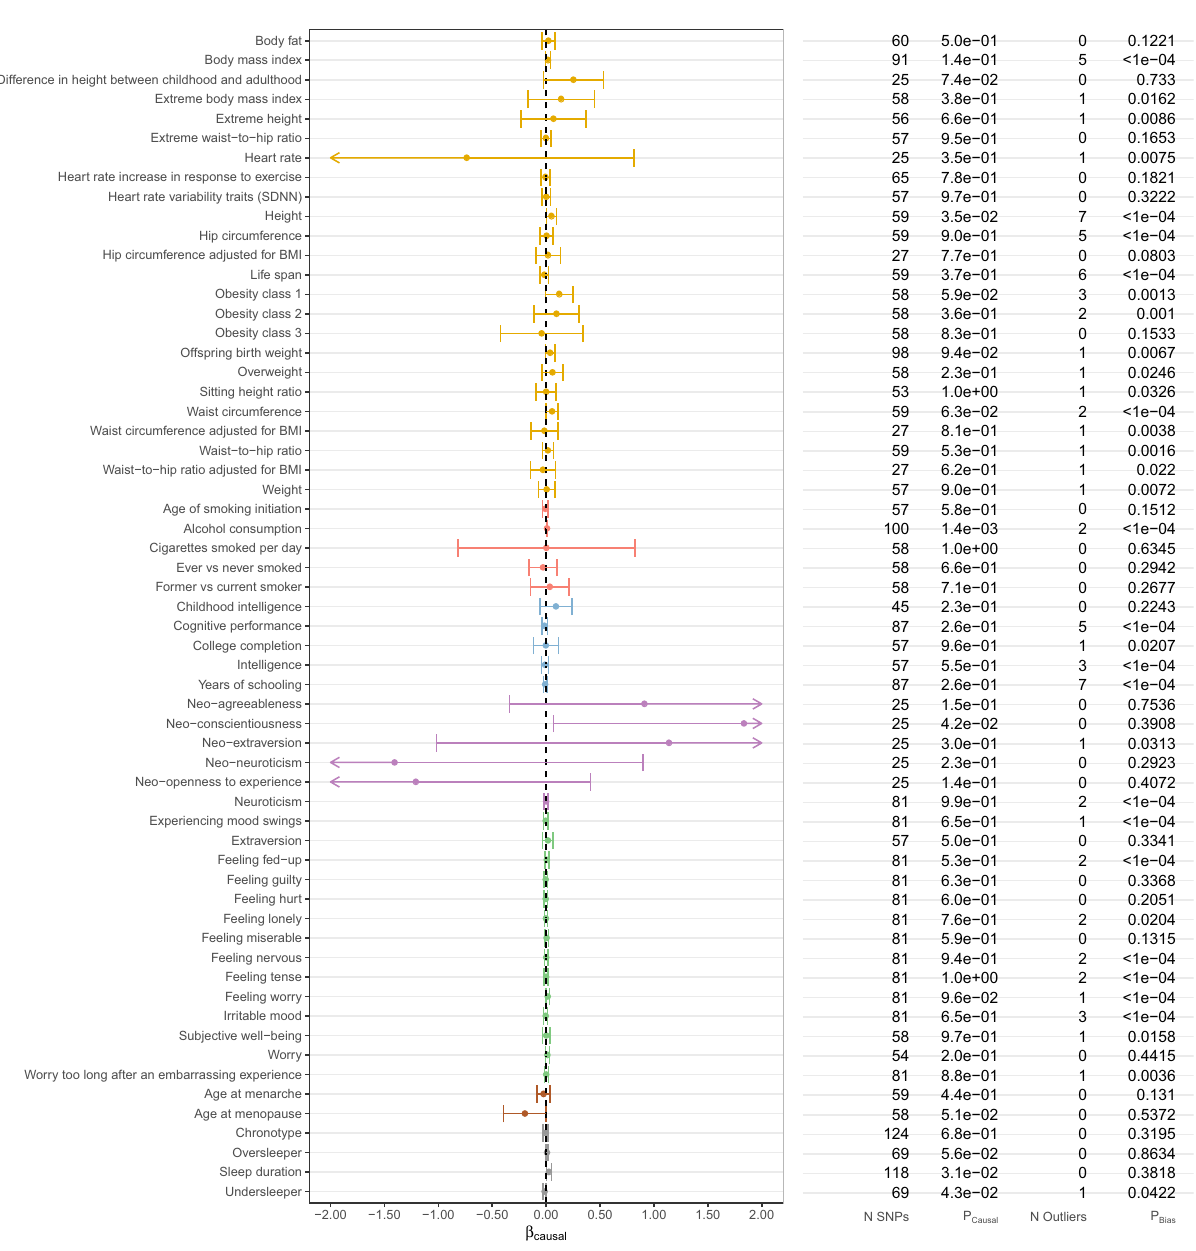
Figure 2. Estimated causal effects of 25(OH)D on complex traits based on the MR-PRESSO approach using 138 genome-wide significant, conditionally independent SNPs of 25(OH)D. The β causal corresponds to 1 standard deviation increase in log-transformed vitamin